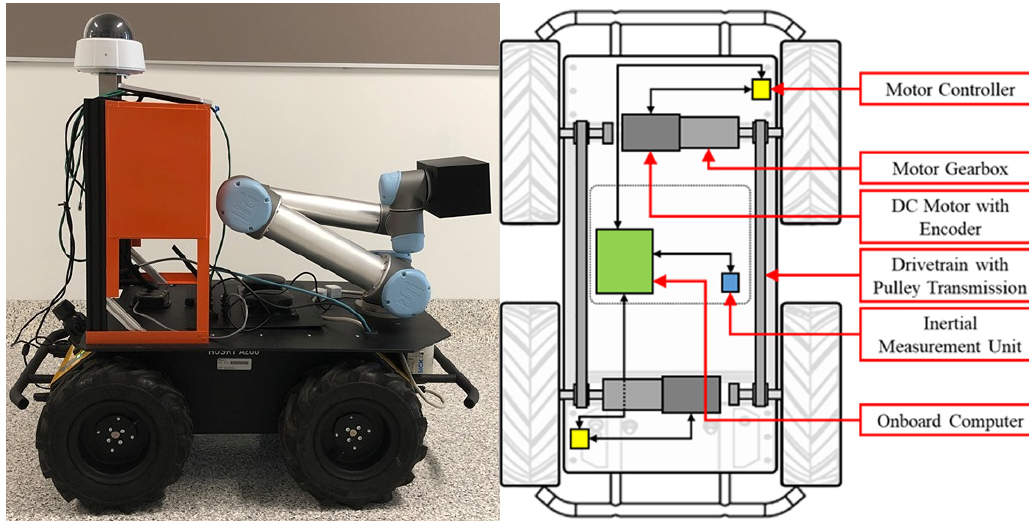
Figure 3. ClearPath Husky mobile robotic system and the diagram of its subsystems.